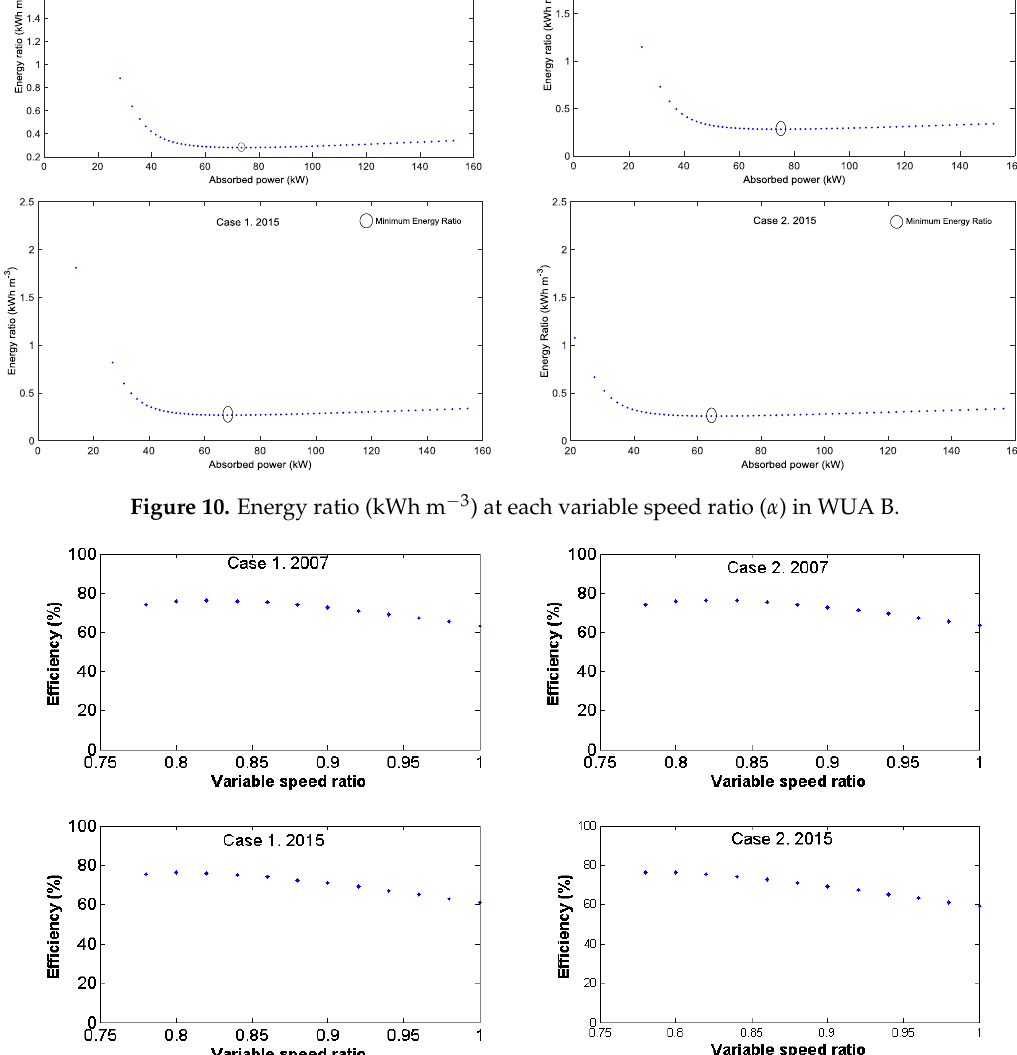
Figure 11. Pump efficiency (%) depending on the variable speed ratio in WUA B.